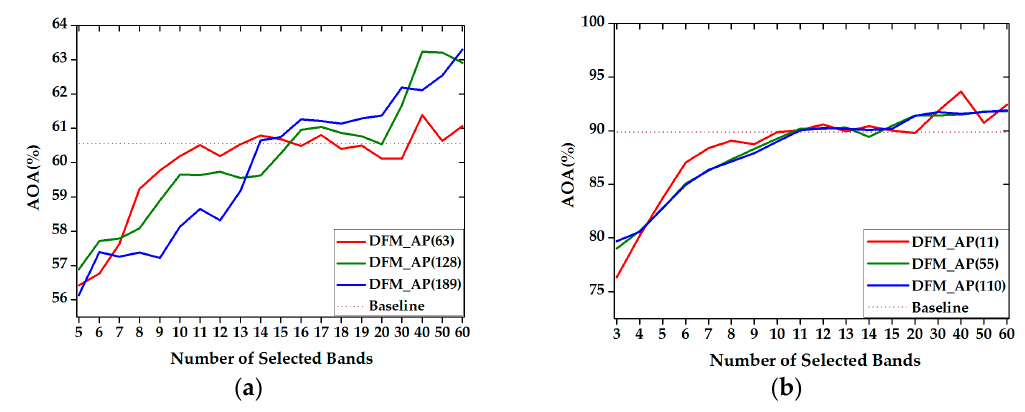
Figure 6. AOA compared to the number of selected bands obtained by the proposed DFM-AP for different numbers of chunklets in the: ( a ) Indian Pines; and ( b ) Xuzhou datasets.